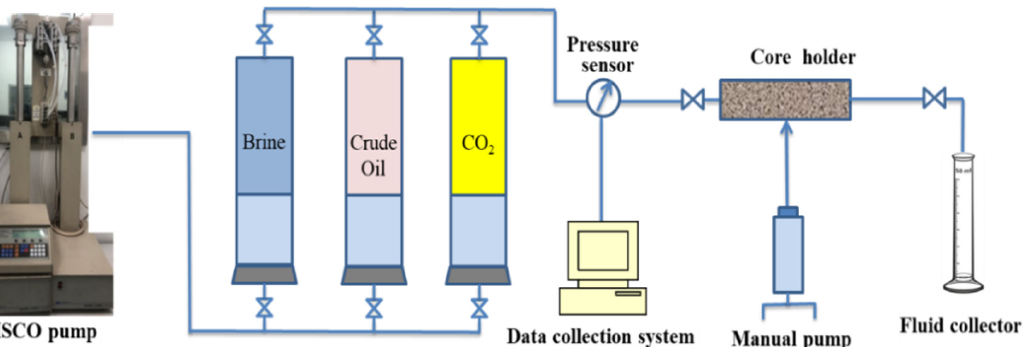
Figure 1. The flow chart of CO 2 flooding experiment.